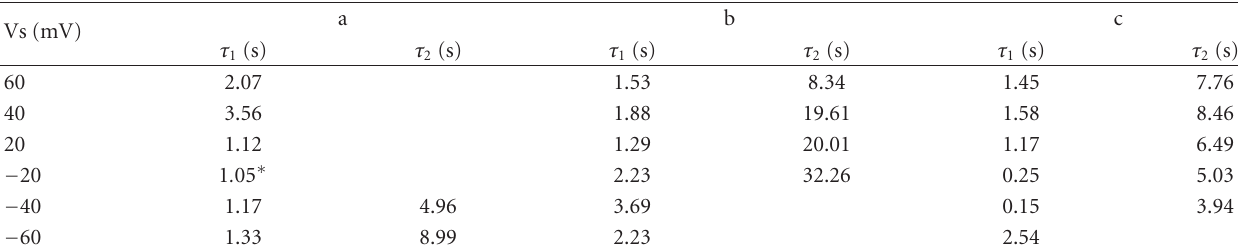
Table 1: The channel lifetime of A β P1-40 in OxCh PLM. The fitted lifetime (see text) of A β P1-40 in the absence (a) and in the presence of choline (5 × 10 − 11 M) added on the cis / trans side of the medium facing the OxCh PLM (b/c, resp.). The minimum and maximum number of channels considered ( N ) out of a total number of channels considered ( N t ) was: (a) 125 < N < 503, N t = 1214; (b) 95 < N < 217,